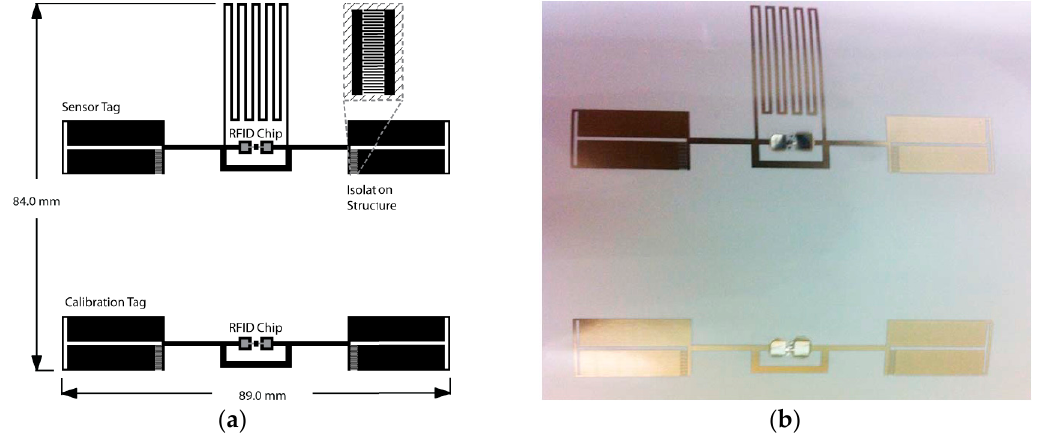
Figure 9. RFID touch sensor (redrawn from [74]): ( a ) layout of chip-based touch sensor and ( b ) fabricated prototype of inkjet-printed RFID touch sensor.